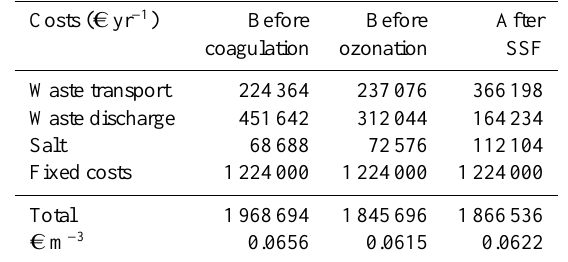
Figure 4: AOC concentrations in the treatment lanes when FIX was posi- Figure 4. AOC concentrations in the treatment lanes when FIX was positioned before ozonation or MIEX was positioned after SSF. Table 5. Total costs of IEX at three di ff erent positions in the treat- ment